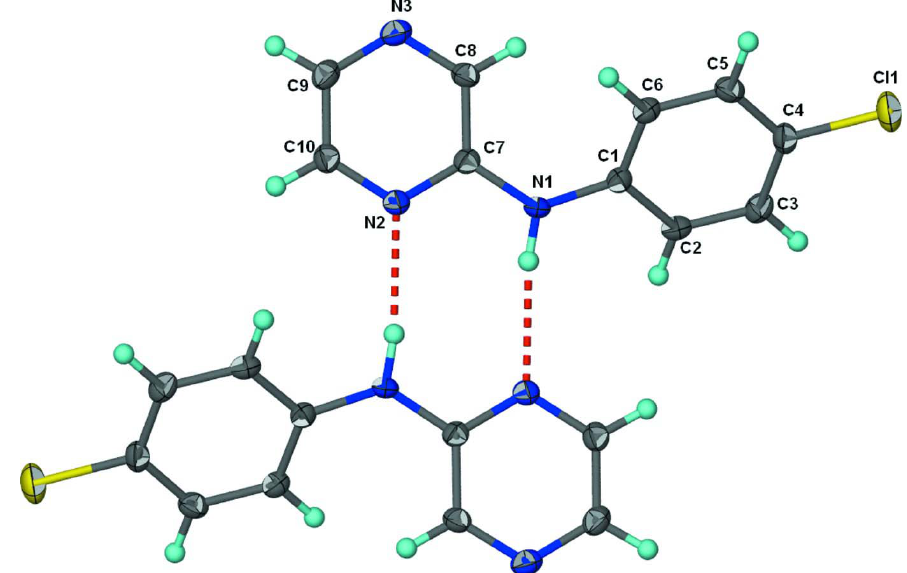
Figure 1 Thermal ellipsoid plot (Barbour, 2001) of hydrogen-bonded dimeric structure of C Hydrogen atoms are drawn as spheres of arbitrary radius. Hydrogen bonds are shown as red dashed